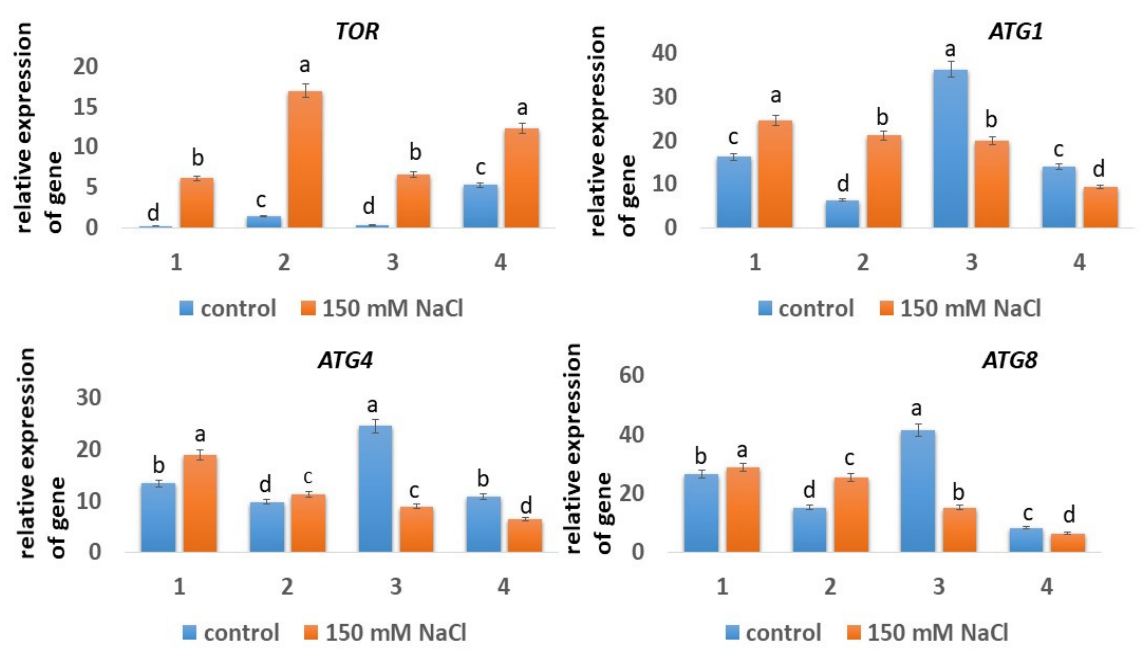
Figure 3. Expression of genes TOR , ATG1 , ATG4, and ATG8 in root (1, 2) and shoot (3, 4) of wheat Orenburgskaya 22 (1, 3) and Zolotaya (2, 4) grown in control condition (1, 2) and in presence of 150 mM NaCl. Bar represent standard deviation, p < 0.05. Different letters indicate significant differences at p < 0.05.